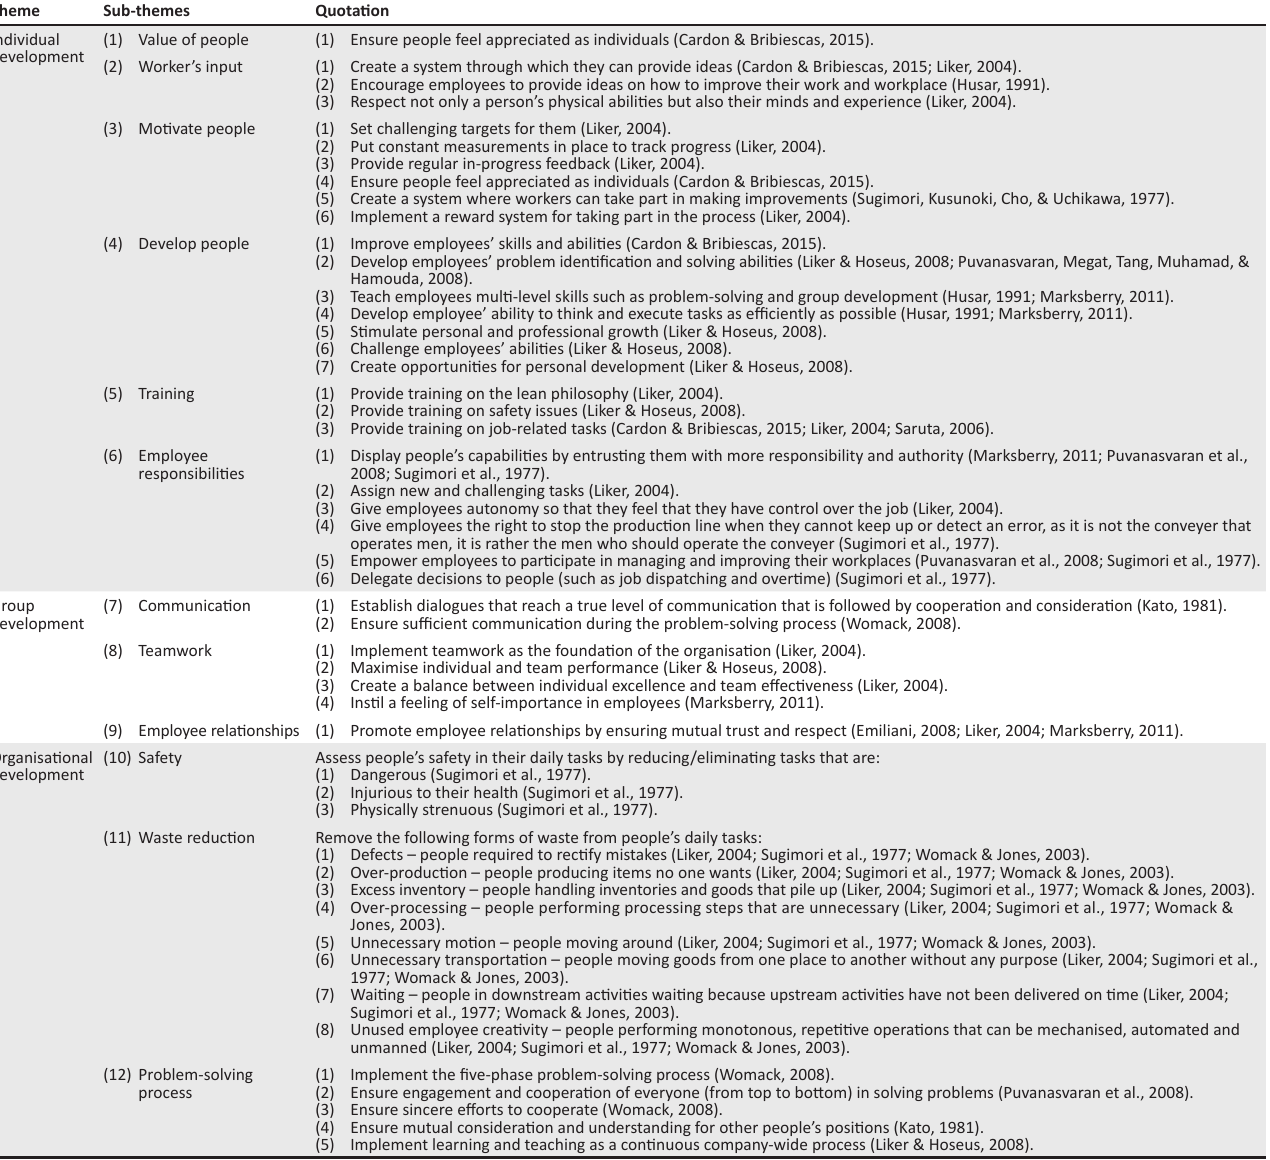
TABLE 1: The original Japanese Respect for People themes.